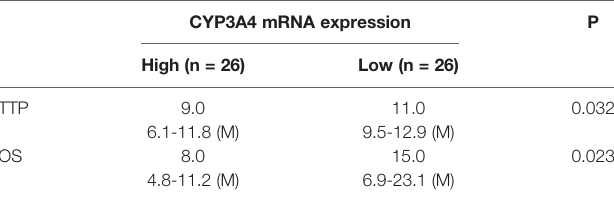
TABLE 1 | CYP3A4 expression and clinical outcome of sorafenib treatment. CYP3A4 mRNA